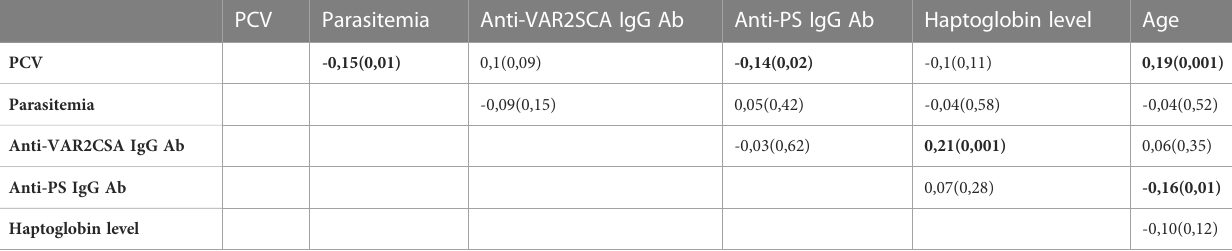
Spearman ’ s correlation coef fi cients between different parameters are shown followed by p values in parentheses. Statistically signi fi cant correlation coef fi cients are shown in bold.